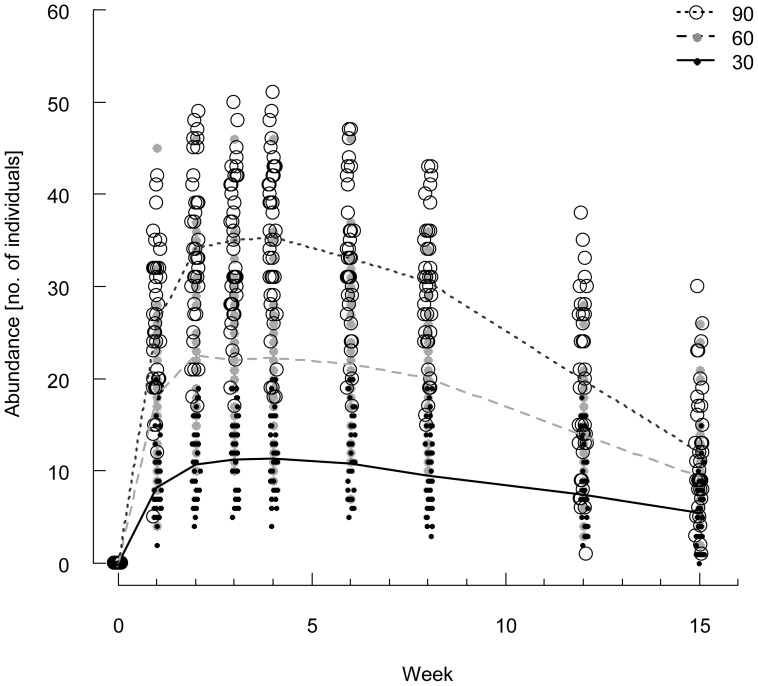
Experiment 1: Temporal development of Senecio vernalis abundance.Data are given separately for seed density levels applied. Open circles depict 90 seeds per container, filled grey circles depict 60 seeds per container, black dots show 30 seeds per container (n = 42 per seed level).